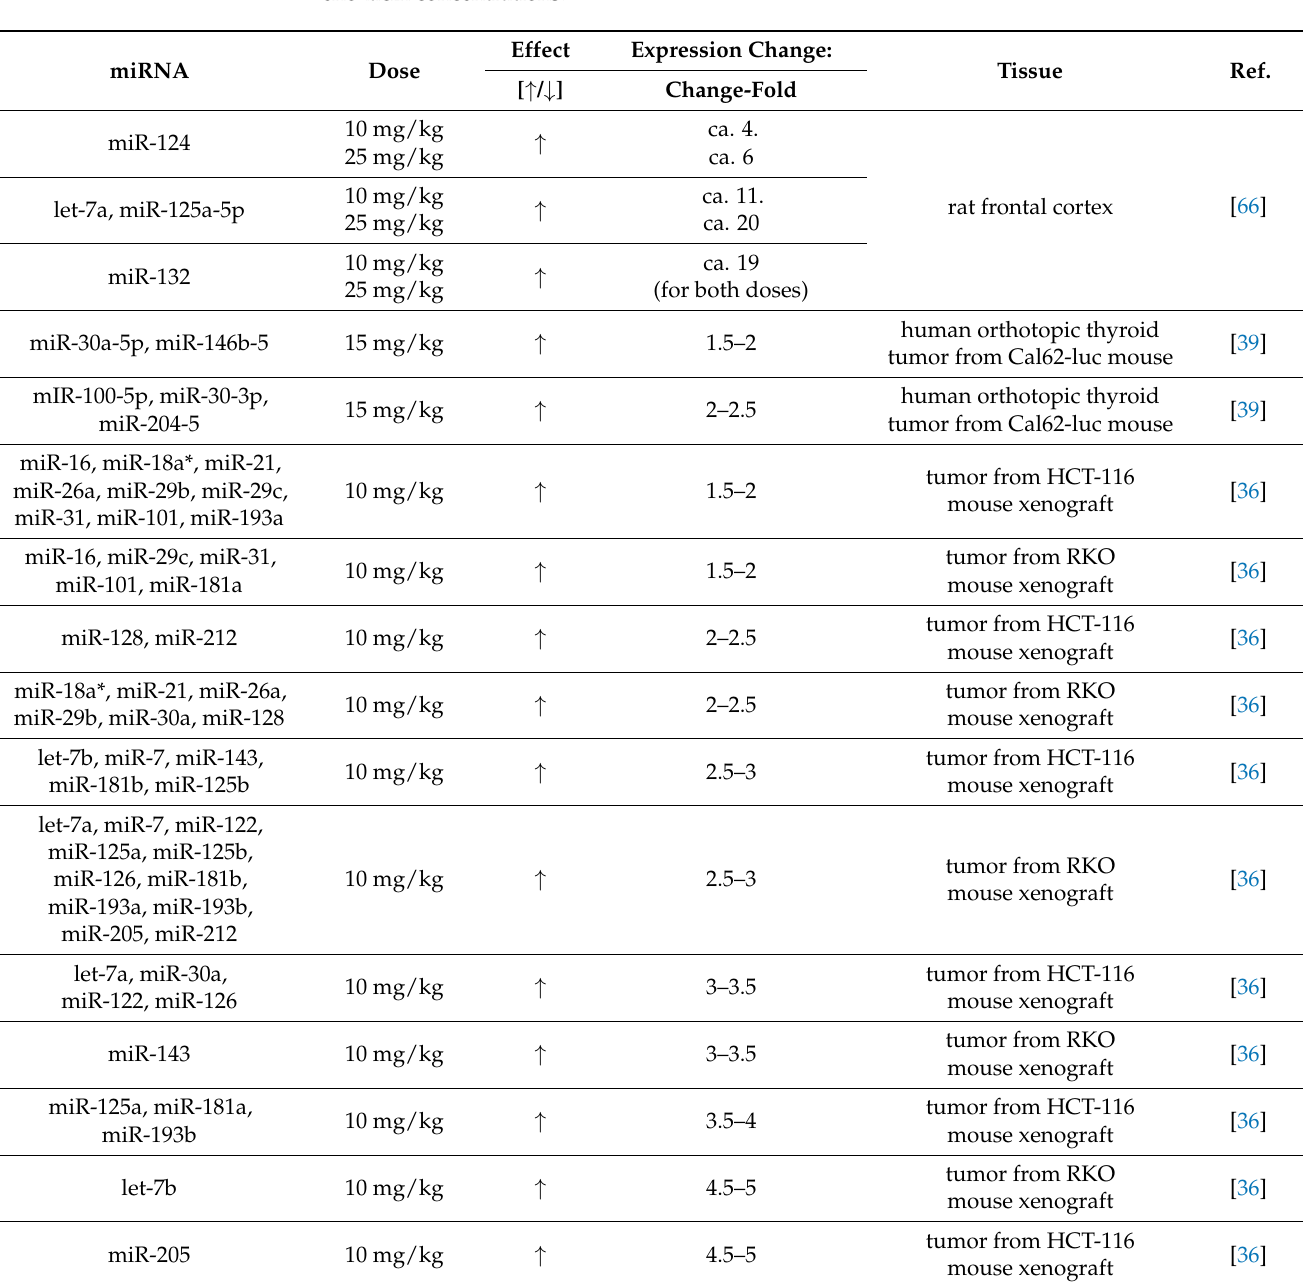
Table 2. The miRNA regulating activity levels in in vivo studies depending on the different enoxacin